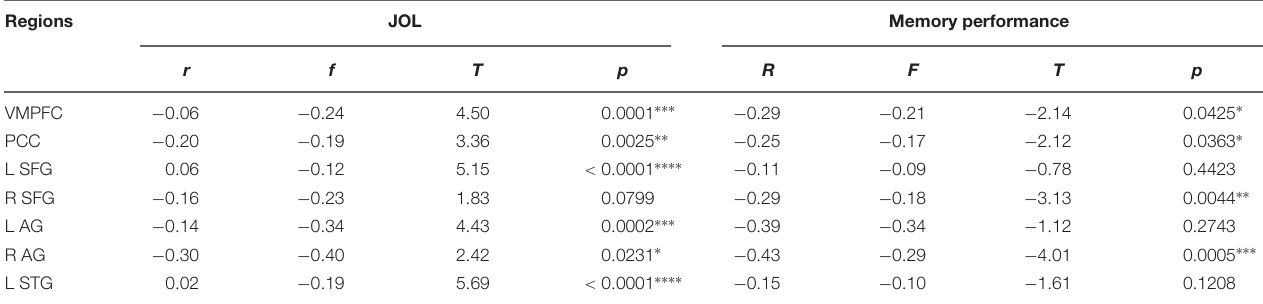
TABLE 2 | Activation differences related to later memory performance and JOL. Regions